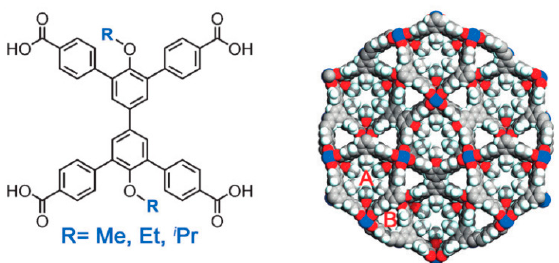
Figure 25. Structure of the FJI-H11-R framework and its rotor linker. Adapted with permission from [109]. Copyright Wiley-VCH, 2016.